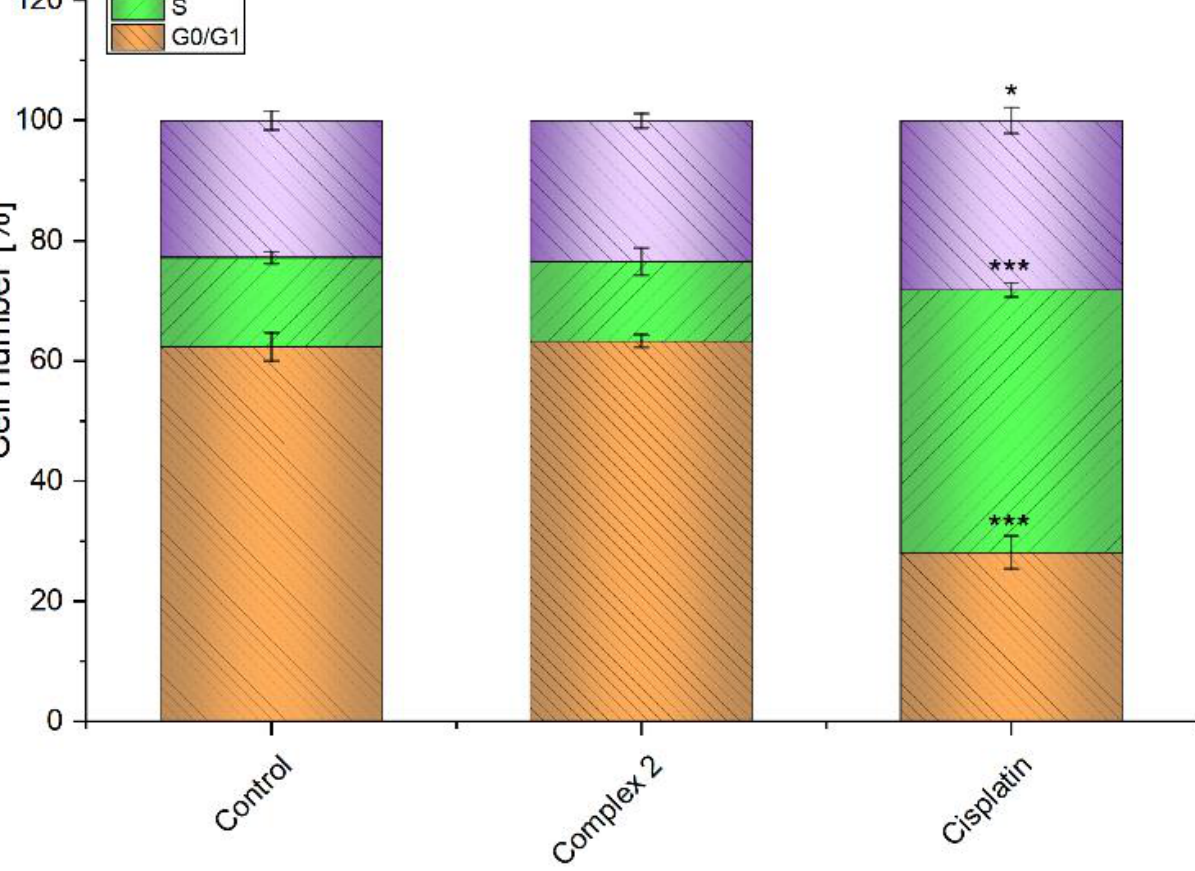
Figure 5. Cell cycle modifications of the A2780 cells induced by complex 2 (applied at 3 µ M concen-